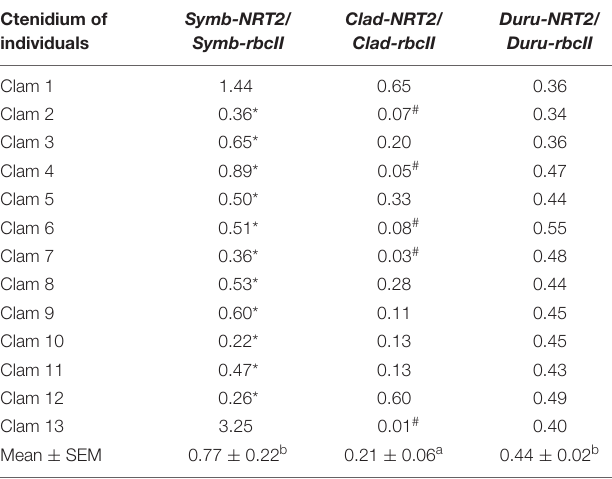
TABLE 8 | Ratios of the transcript levels of nitrate transporter 2 ( NRT2 ) to that of form II ribulose-1,5-bisphosphate carboxylase/oxygenase (rbcII) from Symbiodinium (Symb-NRT2/Symb-rbcII), Cladocopium (Clad-NRT2/Clad-rbcII), and Durusdinium (Duru-NRT2/Duru-rbcII) obtained from the ctenidium of Tridacna squamosa ( n =